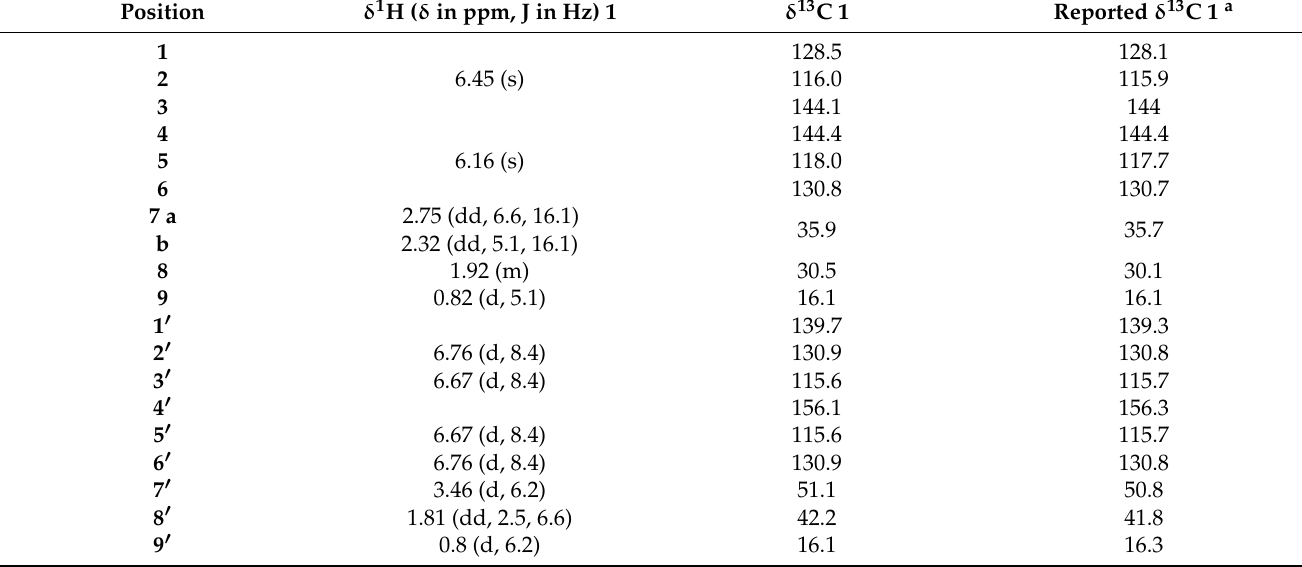
Table 3. 1 H and 13 C NMR data of nor 3 (cid:48) -demethoxyisoguaiacin ( 1 , 600 and 150 MHz, CD 3